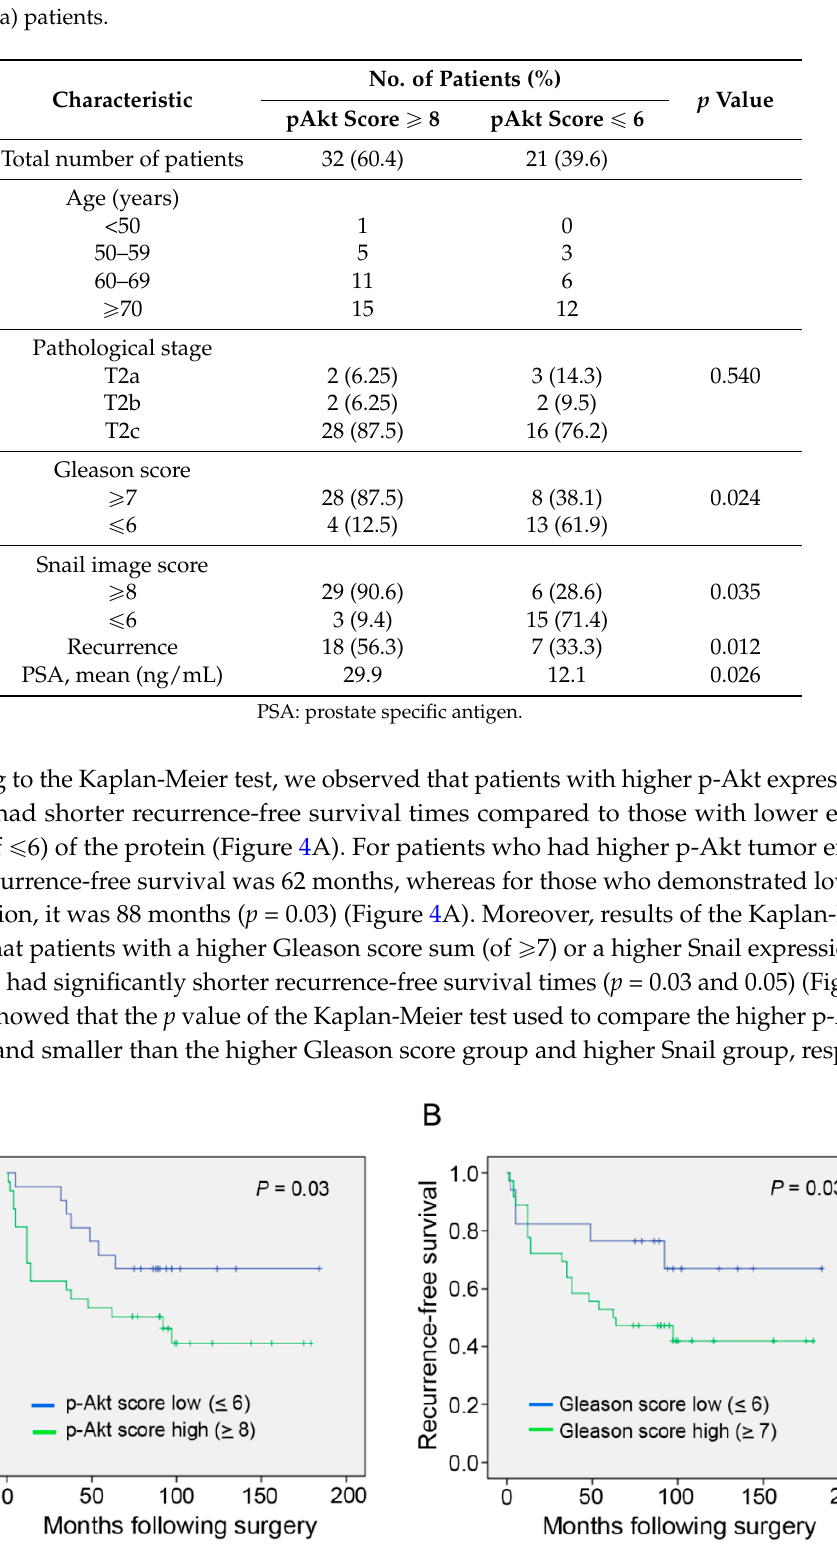
Figure 4. Cont. Figure 4.